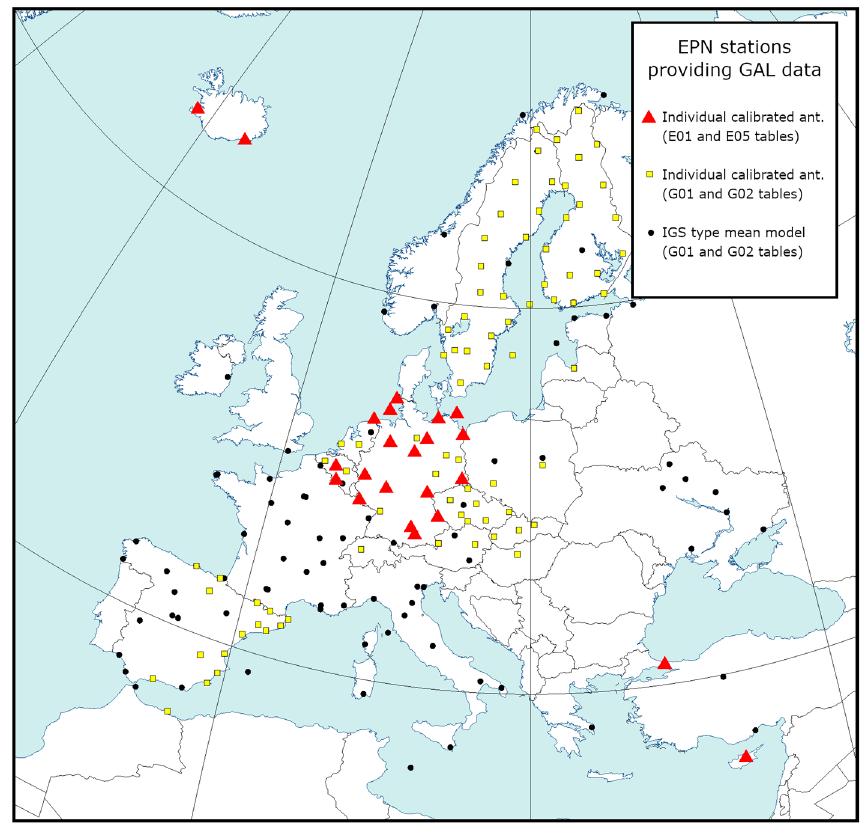
Figure 1. EPN stations providing the Galileo (GAL) observations between 30 June and 6 July 2019 (GPS week 2060) used in this study. NYA200NOR is outside of the presented area and is not plotted on the map.